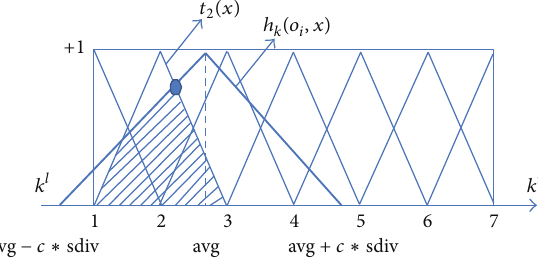
Figure 1: Target-oriented